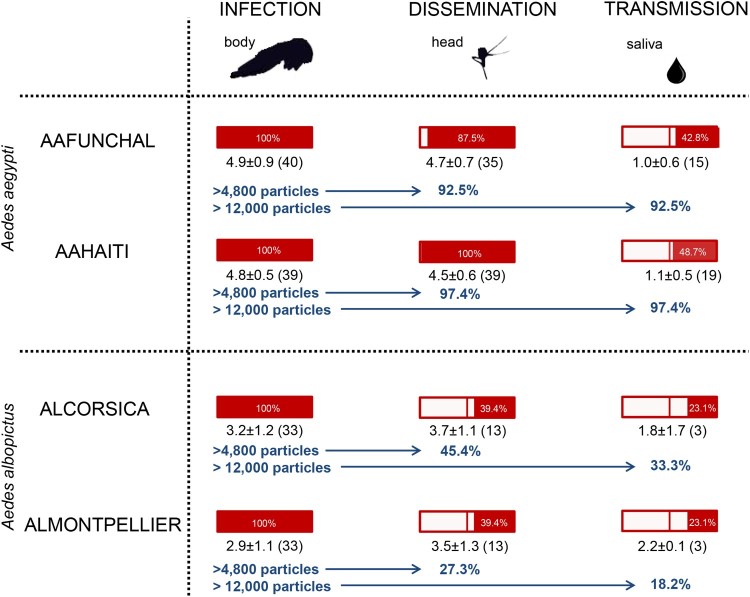
Infection, dissemination and transmission rates of Aedes aegypti (AAFUNCHAL and AAHAITI) and Aedes albopictus (ALCORSICA and ALMONTPELLIER), 14 days after infection with ZIKV Martinique provided at a titer of 107 TCID50/mL. Body (Abdomen plus thorax), head and saliva were titrated on Vero cells to evaluate respectively infection, dissemination and transmission rates (rectangle in red). The mean number of viral particles is provided under each rectangle. The proportion of mosquitoes that meet the two criteria: ≥4800 viral copies and ≥12,000 viral copies in body needed to trigger dissemination and transmission respectively, were presented for each mosquito population.